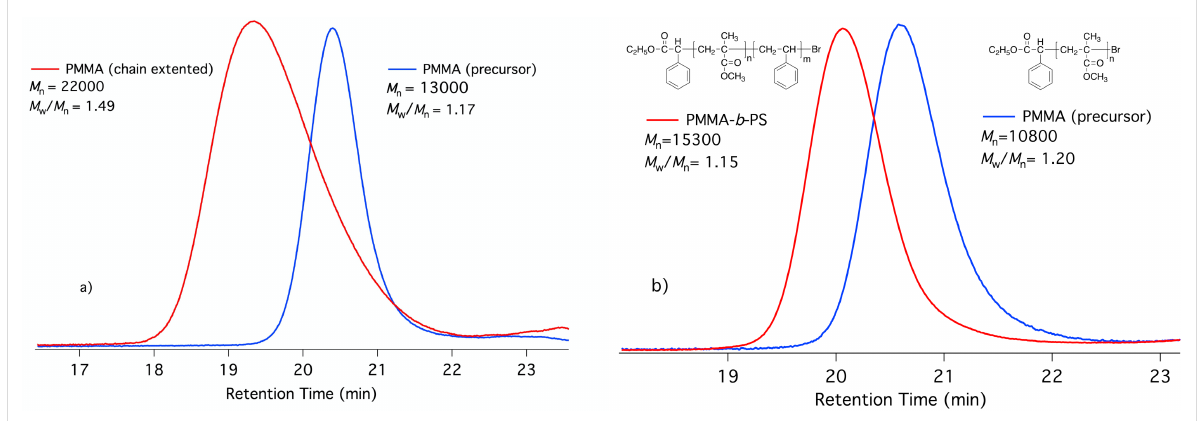
Figure 4: Comparison of the GPC traces of precursor PMMA with a) chain extended PMMA and b) PMMA-b-PS. Conditions for MMA macroinitiator).